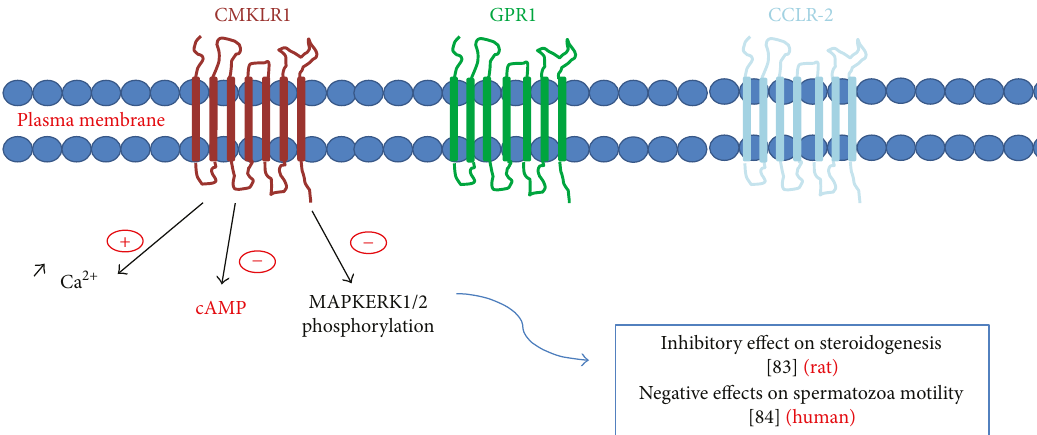
Figure 3: The three transmembrane receptors (CMKLR1, GPR1, and CCLR-2) and its known interactions to male fertility [83,